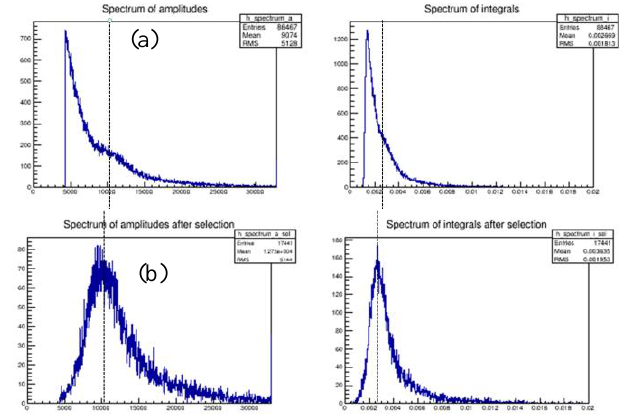
Fig. 10. The amplitude and the energy spectrum from one scintillating element before (a) and after (b) the selection of events with penetrating muons (events with more hitting scintillating